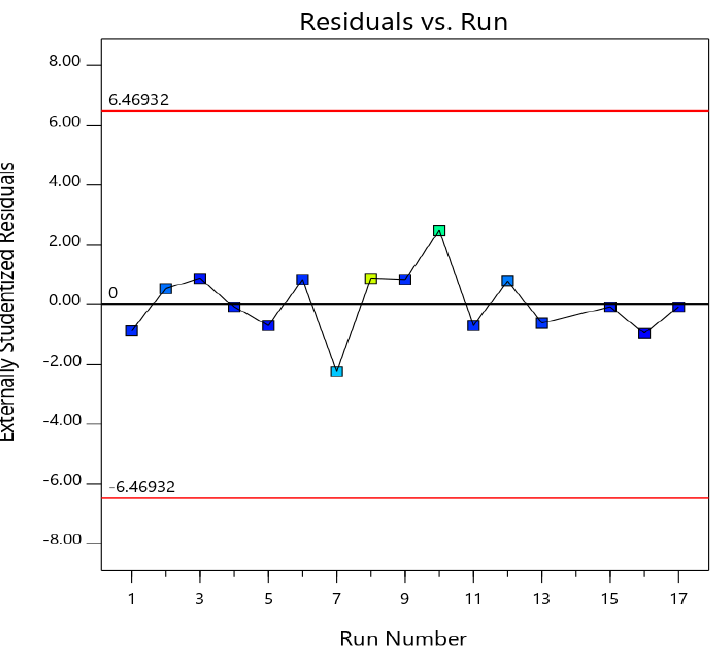
Figure 1. Externally studentized residuals vs. run number for the quadratic × cubic model for luliconazole spanlastics particle size.